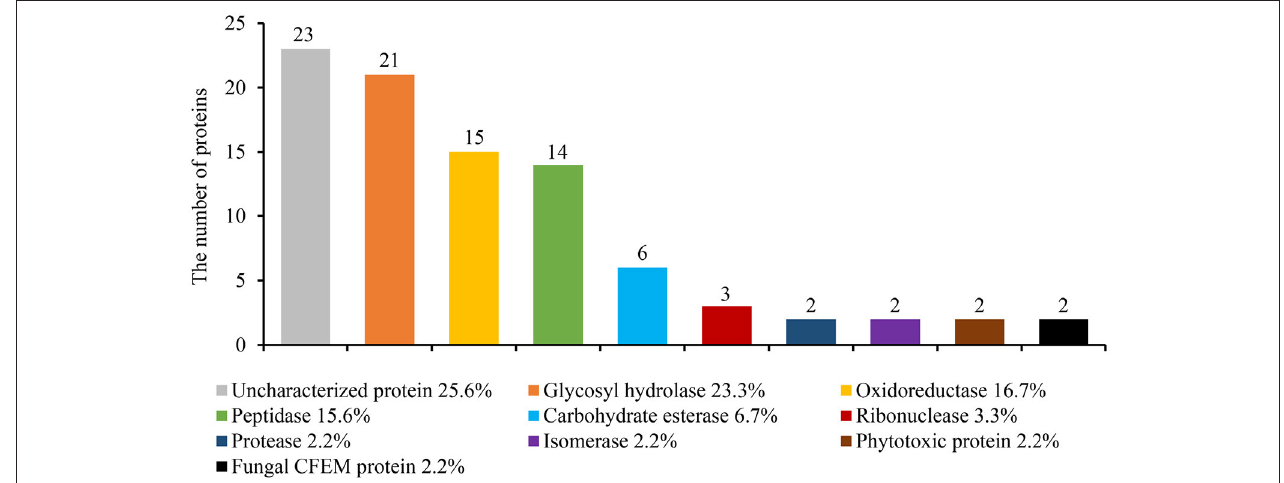
FIGURE 1 | Identifying the S. turcica secreted proteins by liquid chromatography-mass spectrometry (LC-MS/MS). S. turcica was cultivated for 5 days in a potato liquid medium, the supernatant was collected, and the mycelium and impurities were removed through ultrafiltration tubes. The composition of S. turcica secretory proteome was analyzed by LC-MS/MS. The different colors in the column chart represent different protein families. The numbers and the percentages of different proteins are also